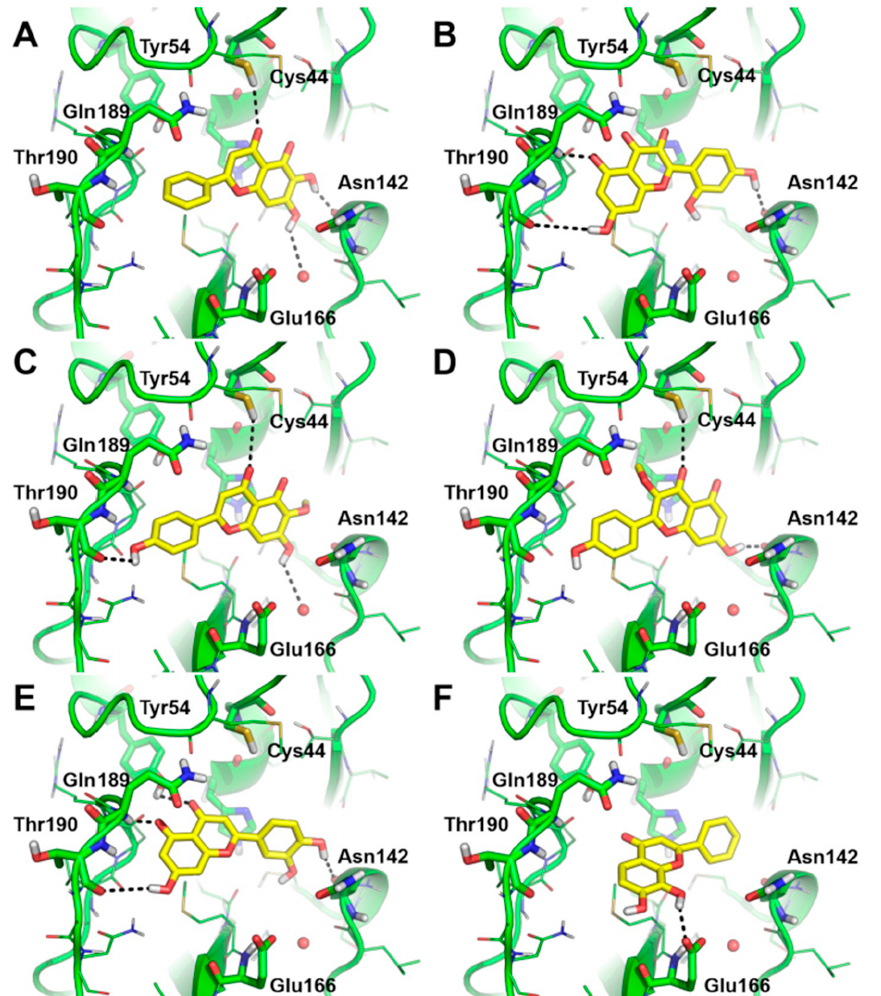
Figure 3. Putative binding modes of the bioactive natural products investigated in this work within the catalytic site of SARS-CoV-2 3CLpro, as predicted by molecular docking simulations. ( A ) Bai- the catalytic site of SARS-CoV-2 3CLpro, as predicted by molecular docking simulations. ( A ) Baicalein; calein; ( B ) Morin; ( C ) Hispidulin; ( D ) Isokaempferide; ( E ) Luteolin; and ( F ) 7,8-dihydroxyflavone. ( B ) Morin; ( C ) Hispidulin; ( D ) Isokaempferide; ( E ) Luteolin; and ( F ) 7,8-dihydroxyflavone. The The protein is shown as a green cartoon and lines (only residues within 6 Å from the ligands are shown, the others are omitted). The ligand polar contacts are highlighted by black dashed lines. The protein is shown as a green cartoon and lines (only residues within 6 Å from the ligands are shown, residues contacted by the ligands are labeled. Natural products are shown as yellow sticks, and non- the others are omitted). The ligand polar contacts are highlighted by black dashed lines. The residues polar H atoms are omitted. contacted by the ligands are labeled. Natural products are shown as yellow sticks, and non-polar H atoms are